Question: Identify the chart type used in this figure.
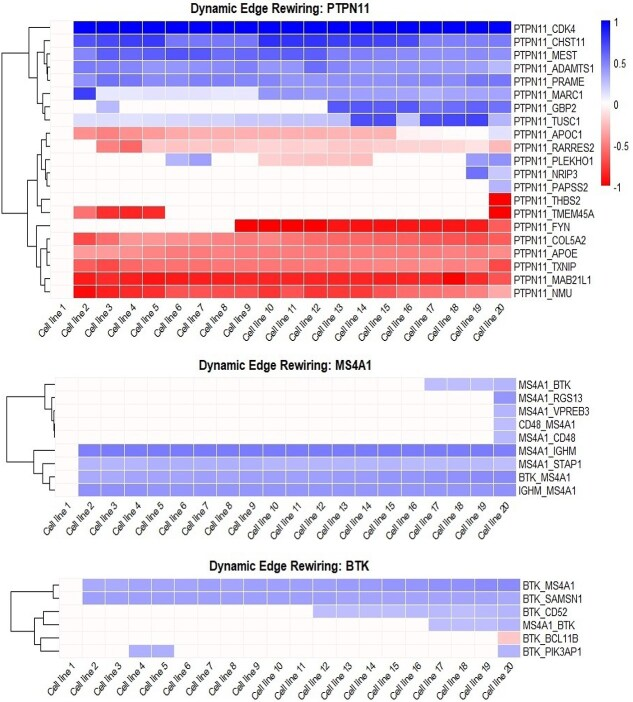
Answer: heatmap